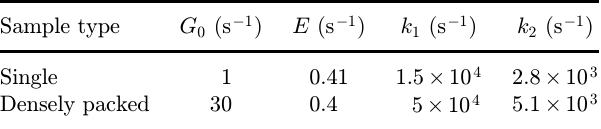
Table 1. Fitting of time domain luminescent intensity of single and densely packed UCNPs to a three-state model. Sample